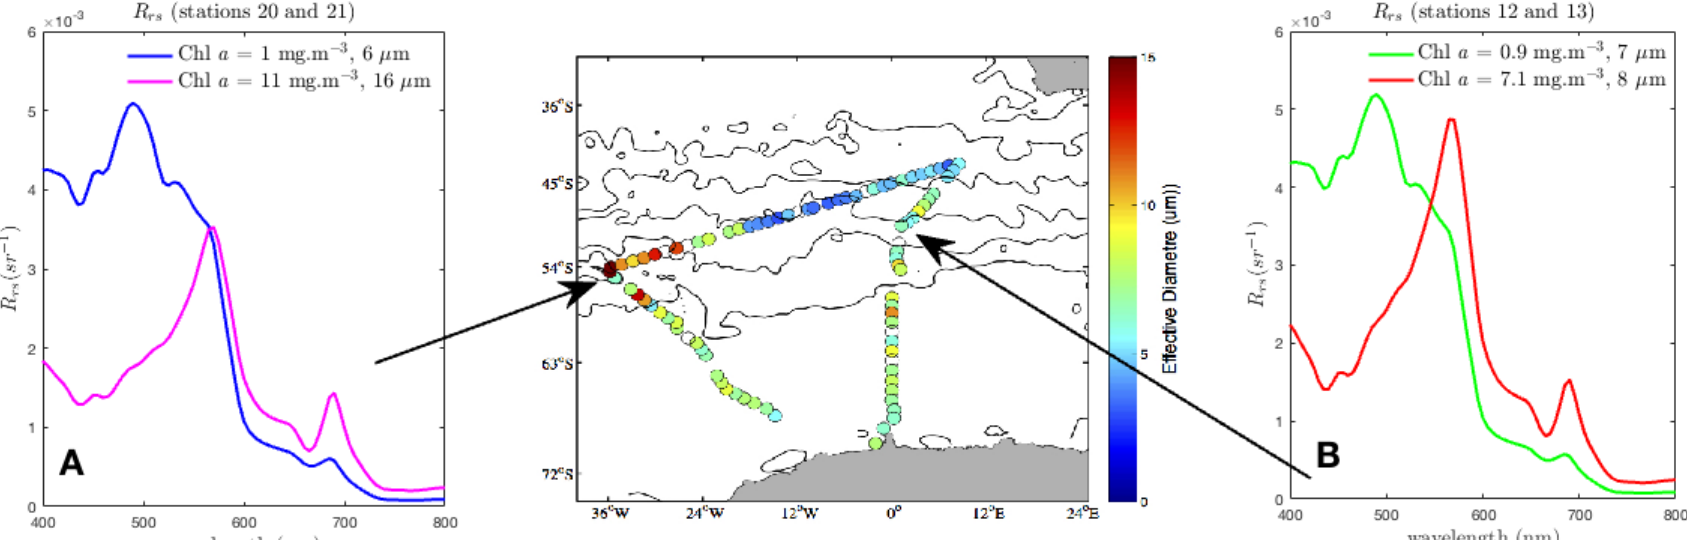
Figure 3. Modelled R rs for stations 20, 21, 12 and 13 of SOSCEX III. The modelled bulk R rs are calculated using Equivalent Algal Populations (EAP) generalised Chl a -carotenoid refractive indices and measured Chl a concentrations for the phytoplankton component, and include estimated a gd ( λ ) and b bnap ( λ ) contributions appropriate for this region [75,76]. Stations 20 to 21 ( A ) represent a large change in both Chl a concentration and in D ef f . Stations 12 to 13 ( B ) represent a large change in Chl a concentration only. The centre panel shows the measured D ef f for the cruise track (starting at the ice shelf on the bottom right and continuing in an anticlockwise direction.) The effective diameter image is courtesy of SANAE 55 Report